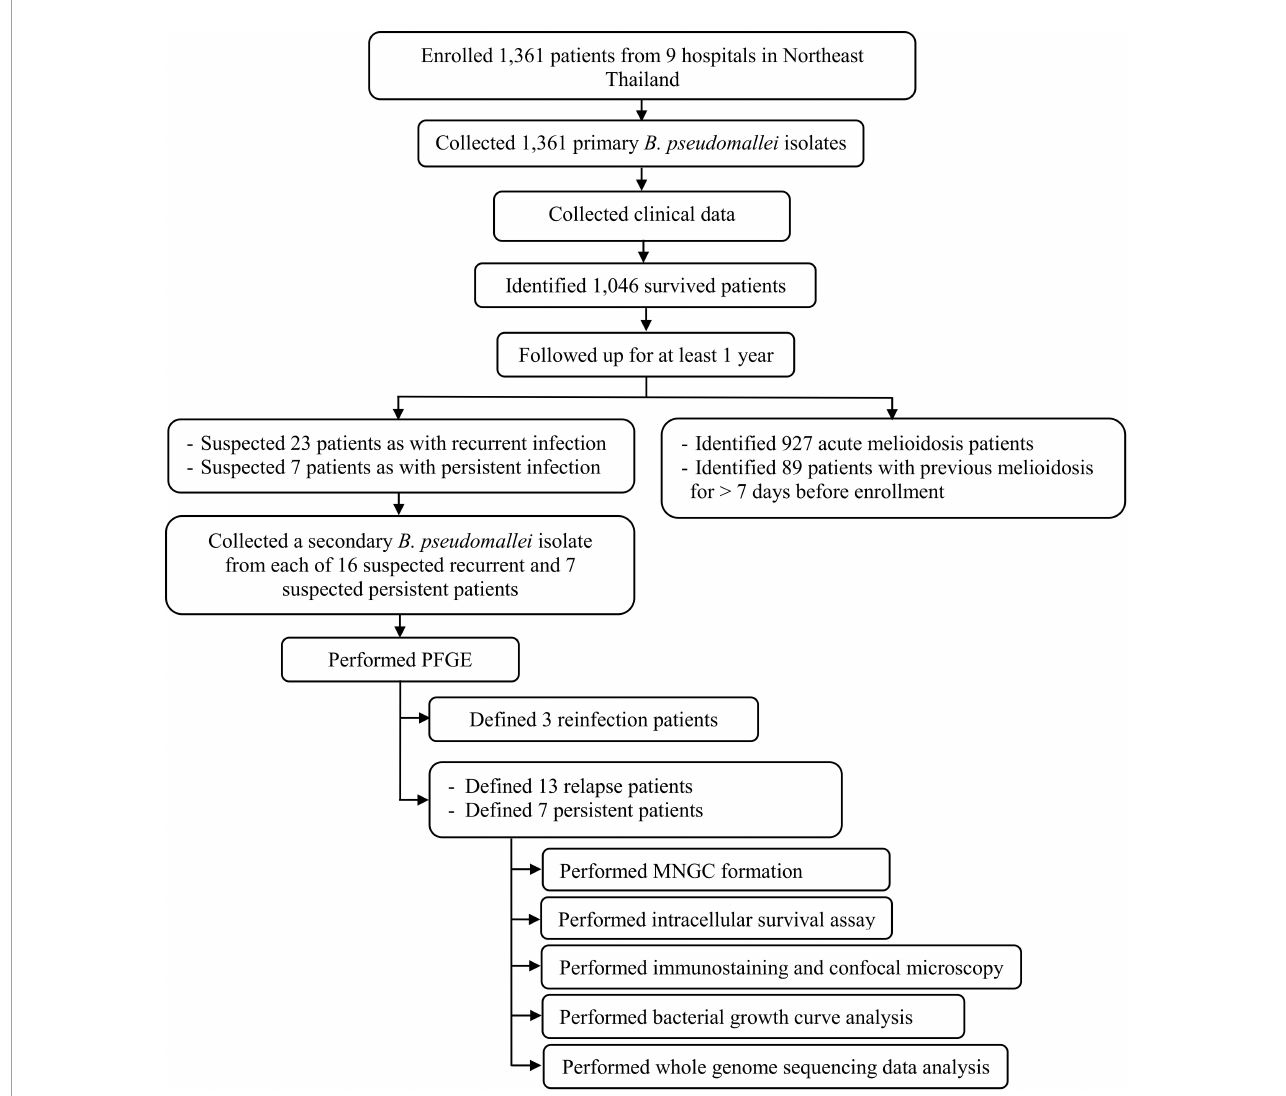
FIGURE1 Flow diagram of study procedures, number of patients, and bacterial isolates used in our cohort.